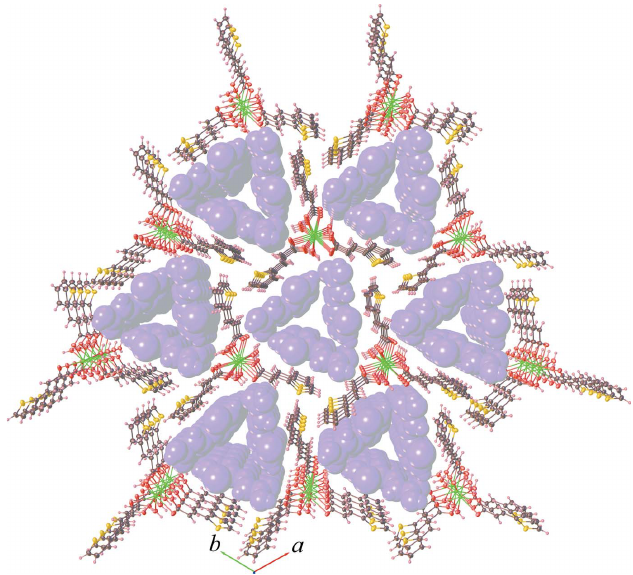
Figure 4 Crystal packing diagram of the title compound 1 , showing the three- dimensional